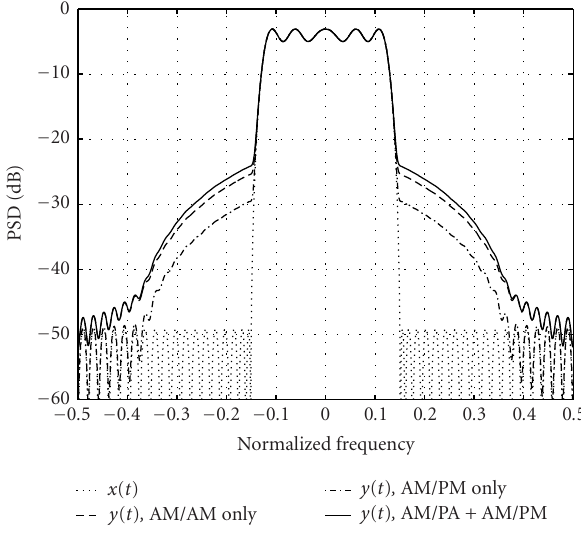
Figure 4: The theoretical S 2 x ( f ) is shown by the dotted line, the theoretical S 2 y ( f ) is shown by the solid line for scenario (i), by the dashed line for scenario (ii), and by the dashed-dotted line for sce- nario